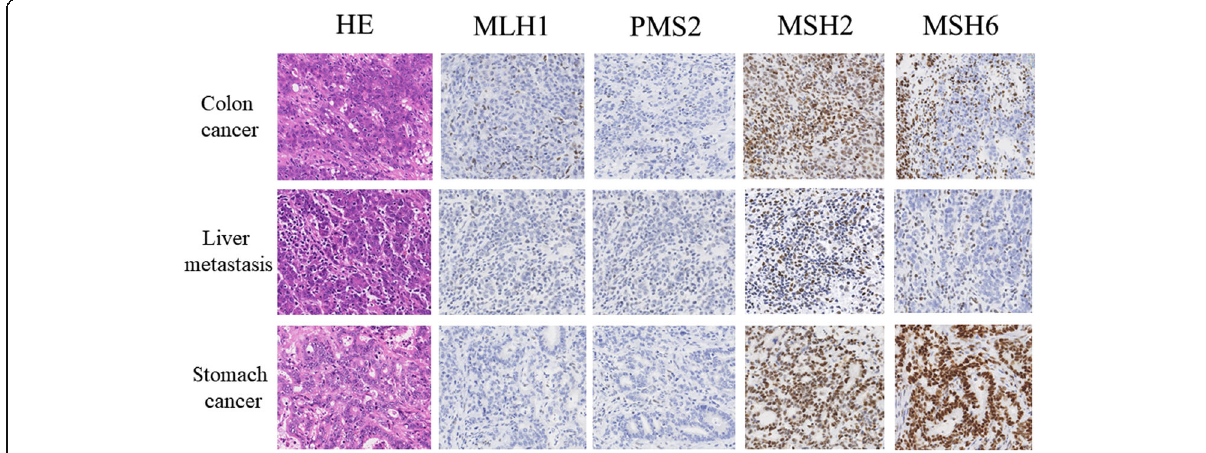
Fig. 2 Histological examination and immunohistochemical staining for mismatch repair proteins of this patient ’ s tumors. HE staining of a colon tumor revealed a poorly differentiated adenocarcinoma with an increased intratumoral lymphocytes and neutrophils. By immunohistochemistry, the tumor is negative for MLH1 and PMS2 . This tumor has intact expression of MSH2. These glands show scanty staining for MSH6. HE staining of a stomach tumor revealed a moderately differentiated